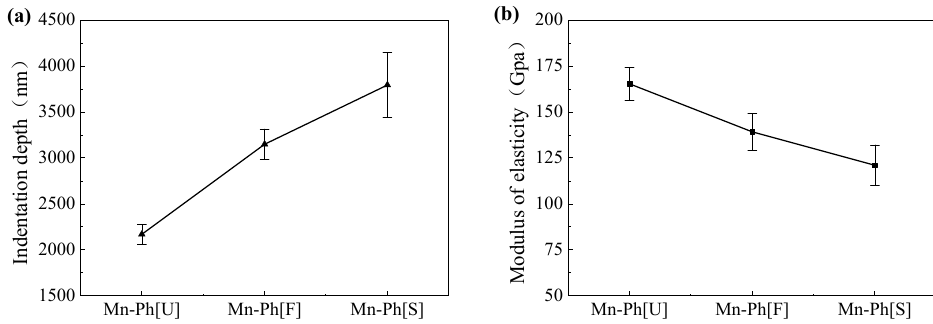
Figure 3. ( a ) The average nanoindentation depth; ( b ) The elastic modulus.